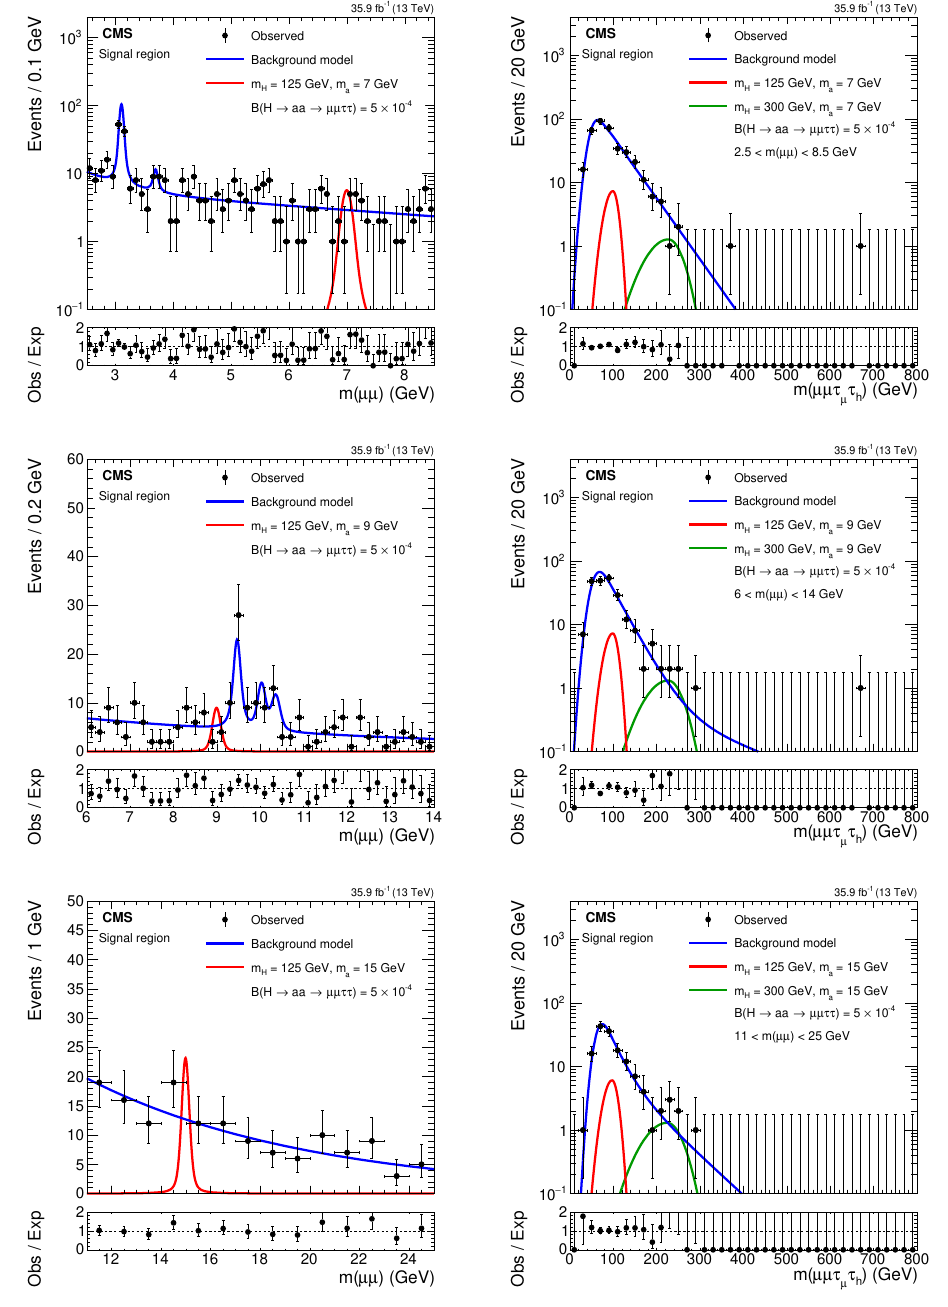
Figure 5 . Projections of 2D background model (cid:12)ts and observed data in the signal region on the m ( (cid:22)(cid:22) ) (left), and m ( (cid:22)(cid:22)(cid:28) (cid:28) ) (right) axes with sample signal distributions that assume H boson (cid:22) h masses of m = 125 and 300 GeV. The (cid:12)gures are divided into three (cid:12)t ranges: 2 : 5 < m ( (cid:22)(cid:22) ) < H 8 : 5 GeV (upper), 6 < m ( (cid:22)(cid:22) ) < 14 GeV (middle), and 11 < m ( (cid:22)(cid:22) ) < 25 GeV (lower).